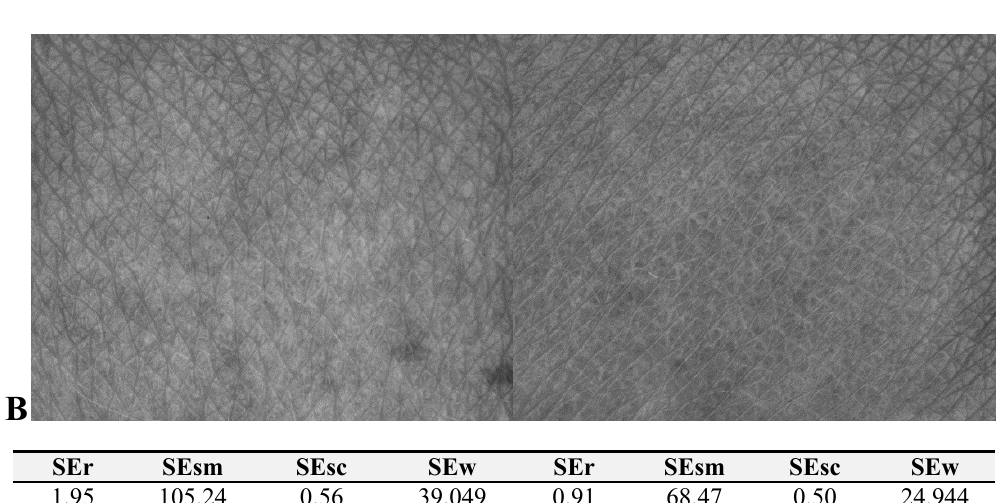
Figure 4. Skin topography images obtained before ( A ) and after application ( B ) of scrub 3 and mask 4 with the corresponding parameters of skin topography.